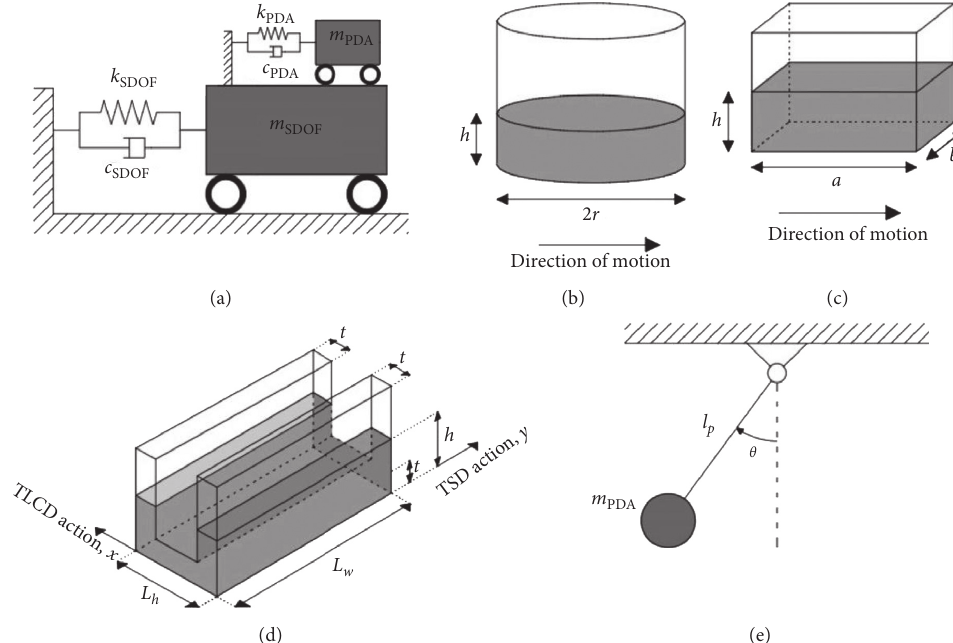
Figure 1: Geometry of the five PDAs. TMD: tuned mass damper; C-TSD: circular tuned sloshing damper; R-TSD: rectangular tuned sloshing damper; TWLD: two-way liquid damper; PTMD: pendulum tuned mass damper. (a) TMD-structure interaction system. (b) C-TSD. (c) R-TSD. (d) TWLD. (e) PTMD. Table 1: Optimum tuning conditions for damped TMDs attached to an undamped primary structure. Loading case Harmonic load applied to primary structure